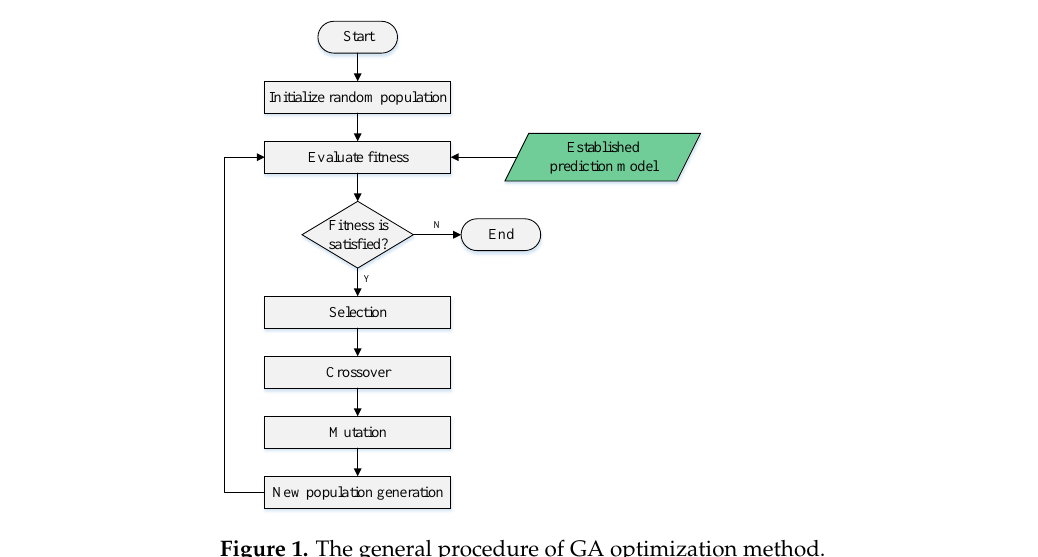
Figure 1. The general procedure of GA optimization